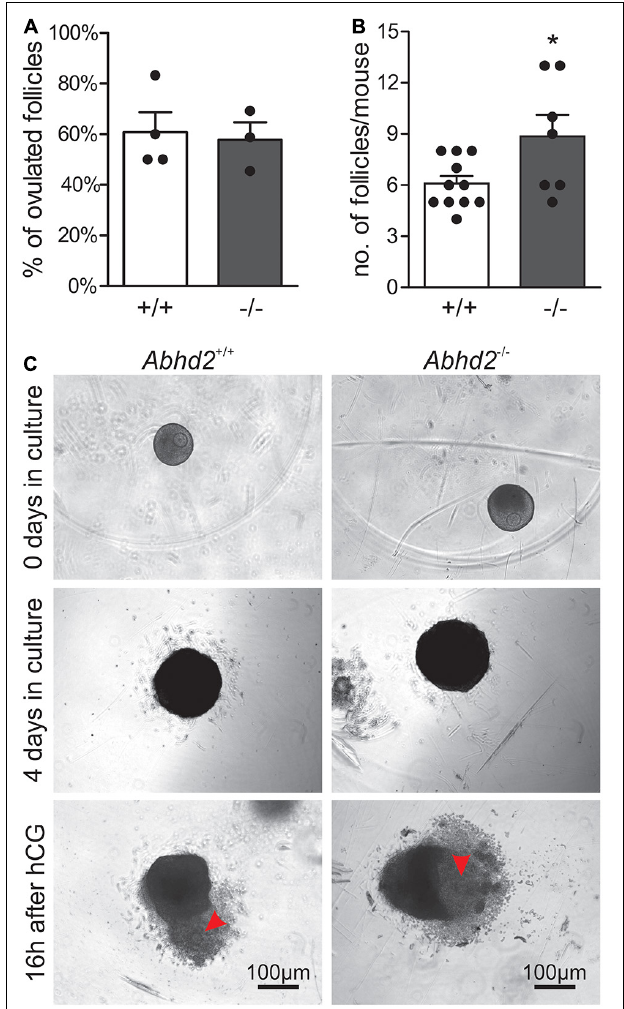
FIGURE 5 | In vitro ovulation. Follicles collected from immature mouse ovaries ( Abhd2 + / + n = 11 and Abhd2 − / − n = 7) were cultured to antral stage, after which ovulation was induced by incubation with hCG. (A) No difference in ovulation efficiency was observed between Abhd2 + / + and Abhd2 − / − mice although (B) the ovaries of Abhd2 − / − mice contained a higher number of large follicles. (C) Representative image of in vitro ovulation of an Abhd2 + / + and an Abhd2 − / − follicle. Statistical significance was calculated using the unpaired t -test and the significance of changes is indicated as follows: * p ≤ 0.05. Using 2–3 mice each time, in vitro ovulation was performed four times for Abhd2 + / + follicles and three times for follicles collected from Abhd2 − / −